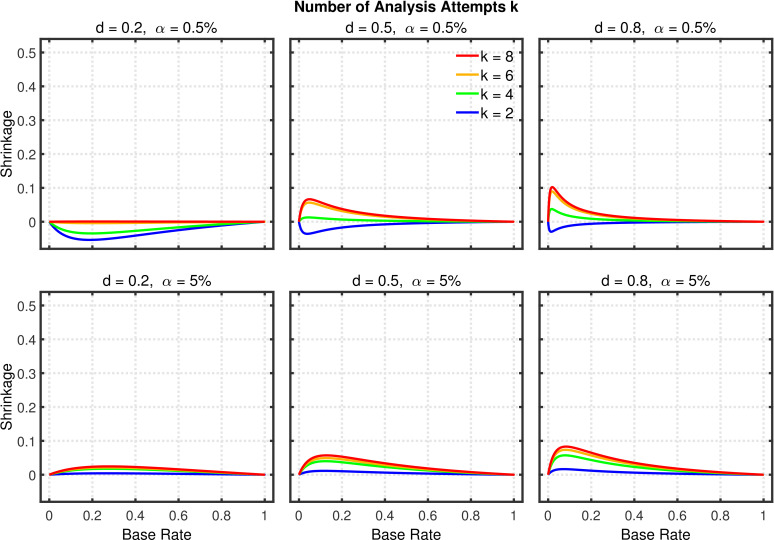
Selective outlier removal.Shrinkage of the replication rate (i.e., the difference between the solid and dashed lines in Figure 13) as a function of base rate π, number k of outlier rejection methods attempted, effect size d, and nominal α level (0.5% or 5%).